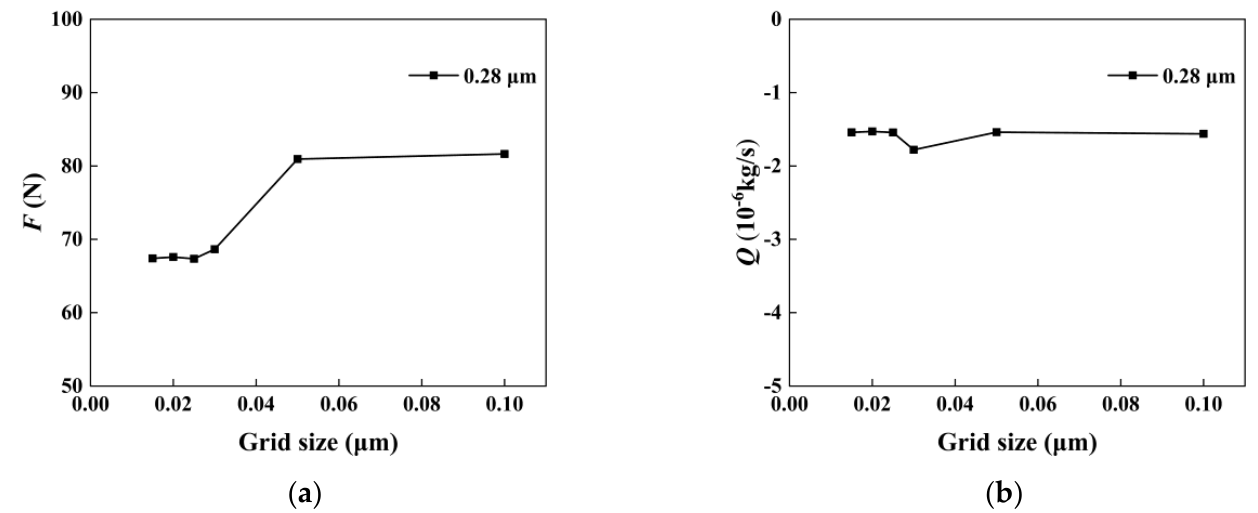
Figure 7. Changes in the sealing performance with the grid size considering the roughness of the stationary ring: ( a ) Changes in the opening force, ( b ) changes in the leakage rate.